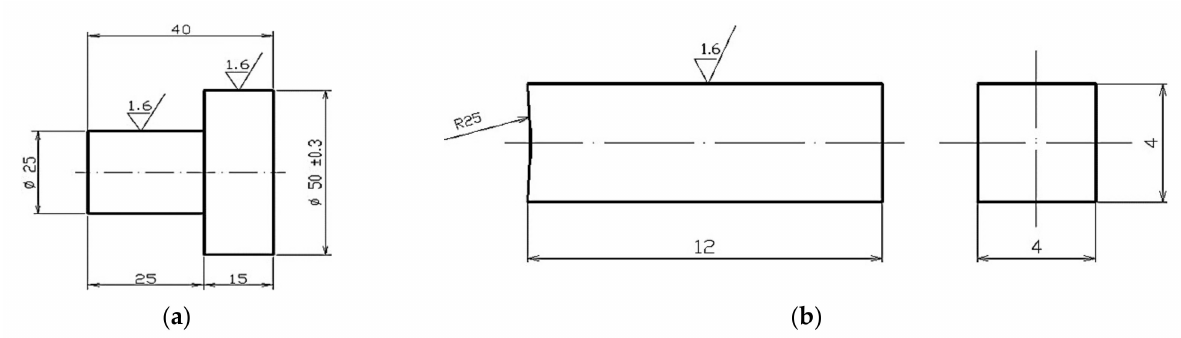
Figure 5. ( a ) The geometry of the abrasive mating part. ( b ) The geometry of the testing sample for detecting the tribological properties of the tested material. Dimensions are in